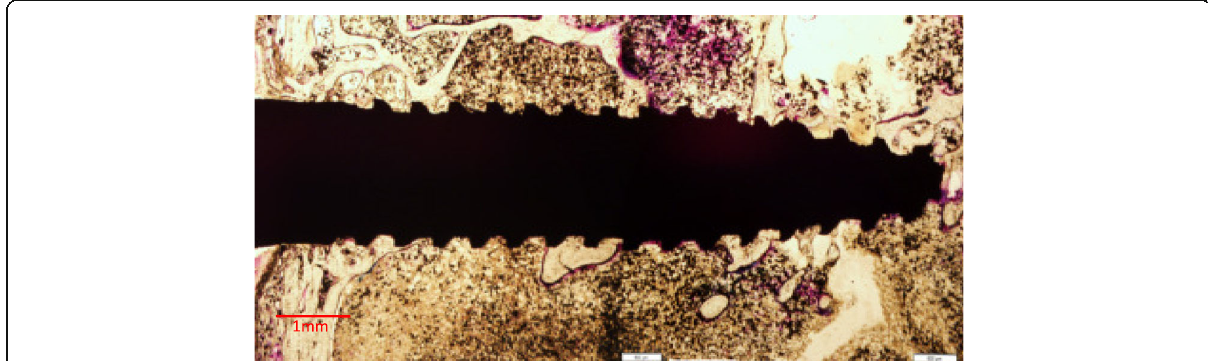
Fig. 4 Histological section of mini dental implant in rabbit tibia stained with methylene blue and basic